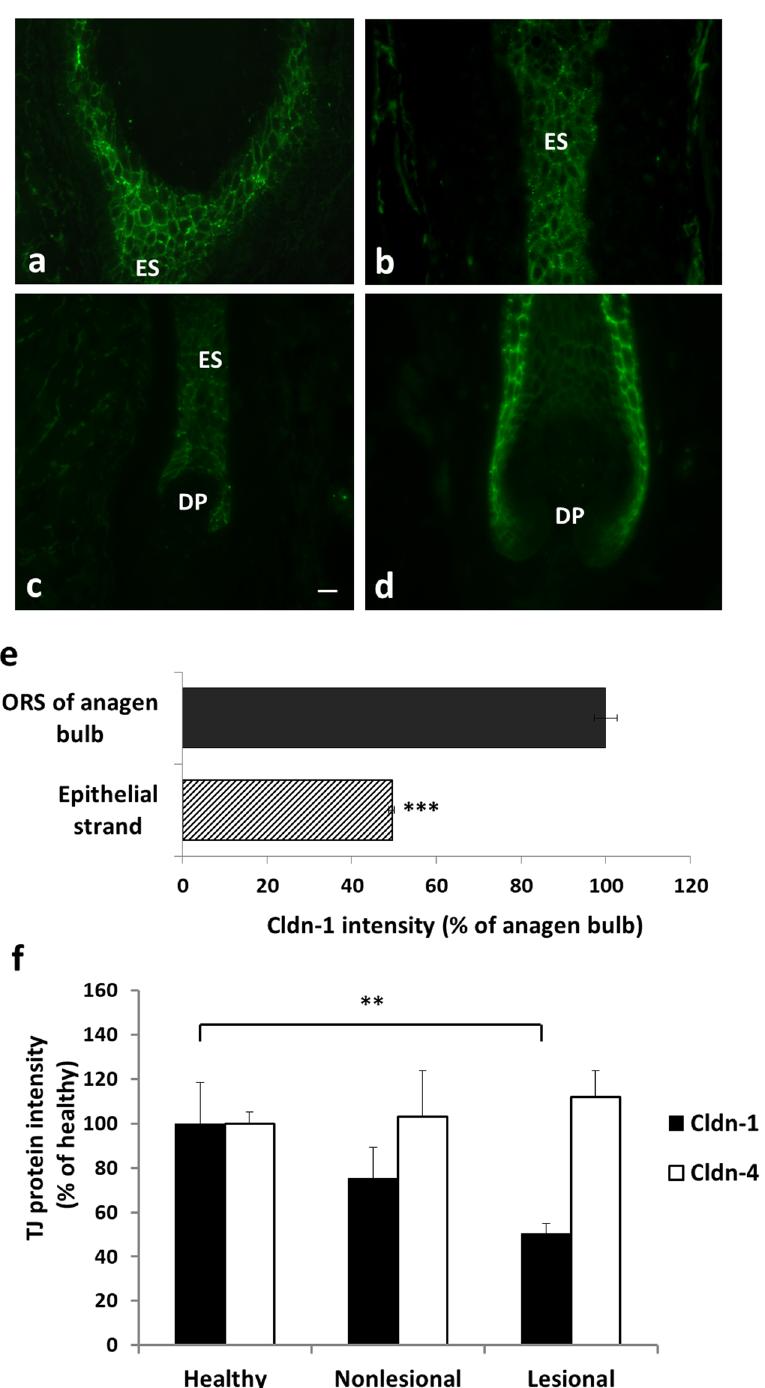
Figure 7. Quantification of Cldn-1 and Cldn-4 in human HFs. Immunohistochemical stainings of Cldn-1 (green; a – d ) in the epithelium around the club hair ( a ), the epithelial strand (ES) ( a , b , c ) of club HF, and in the bulb of an anagen HF ( d ). Scale bar: 20 µ m. ( e ) Quantitative analysis of Cldn-1 intensity in ORS of anagen bulb and epithelial strand during catagen (mean of 23 ROIs ± SEM, n = 3 different donors); ( f ) Cldn-1 and Cldn-4 staining intensity in human anagen HFs of healthy and AD non-lesional and lesional skin; means ± SEM of 10 ROIs per image. Statistical test: ANOVA, significant differences are indicated by *